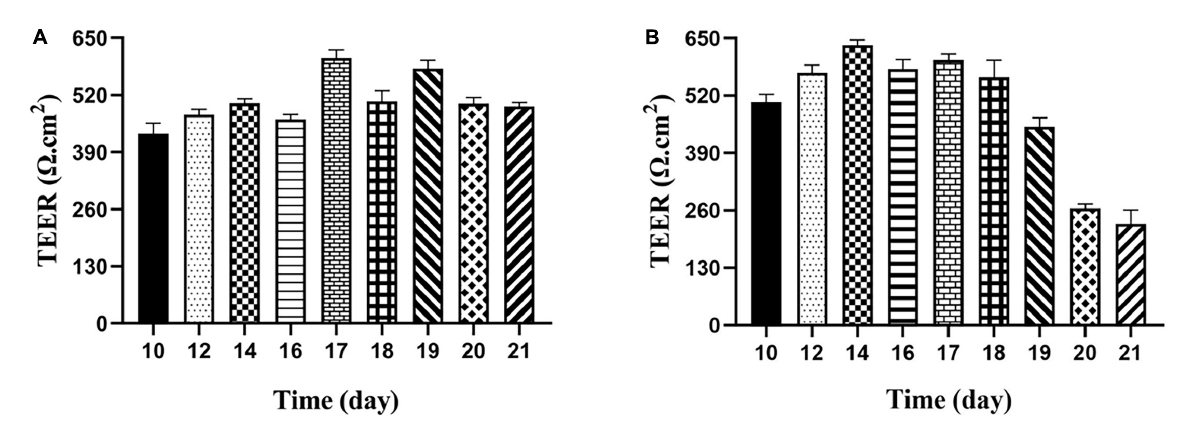
FIGURE4 Transepithelial electrical resistance of Caco-2 monolayer model and M cell model. (A) Transepithelial electrical resistance of Caco-2 monolayer model; (B) transepithelial electrical resistance of M cell model.